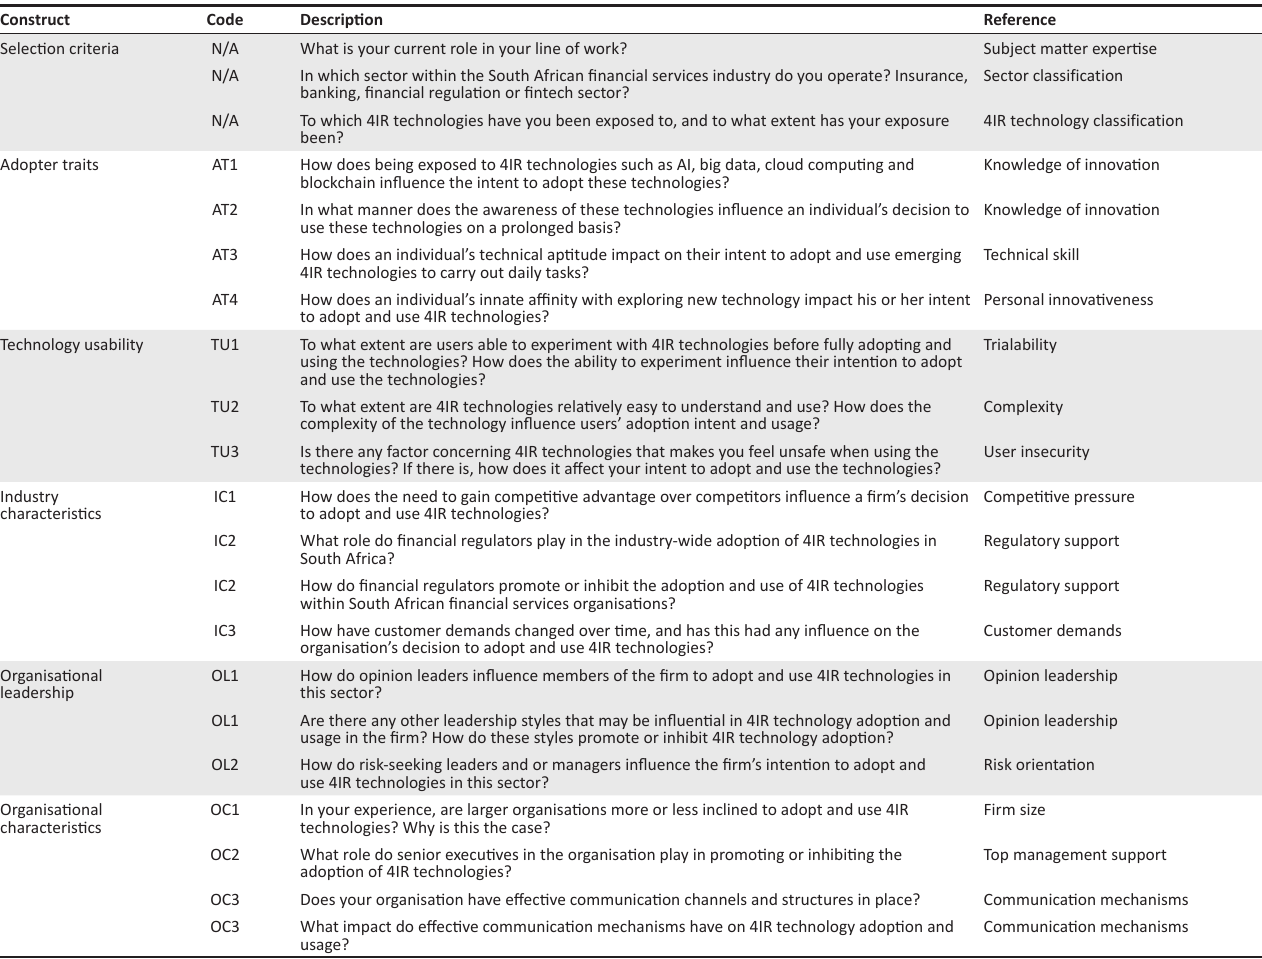
TABLE 1 A1: The research